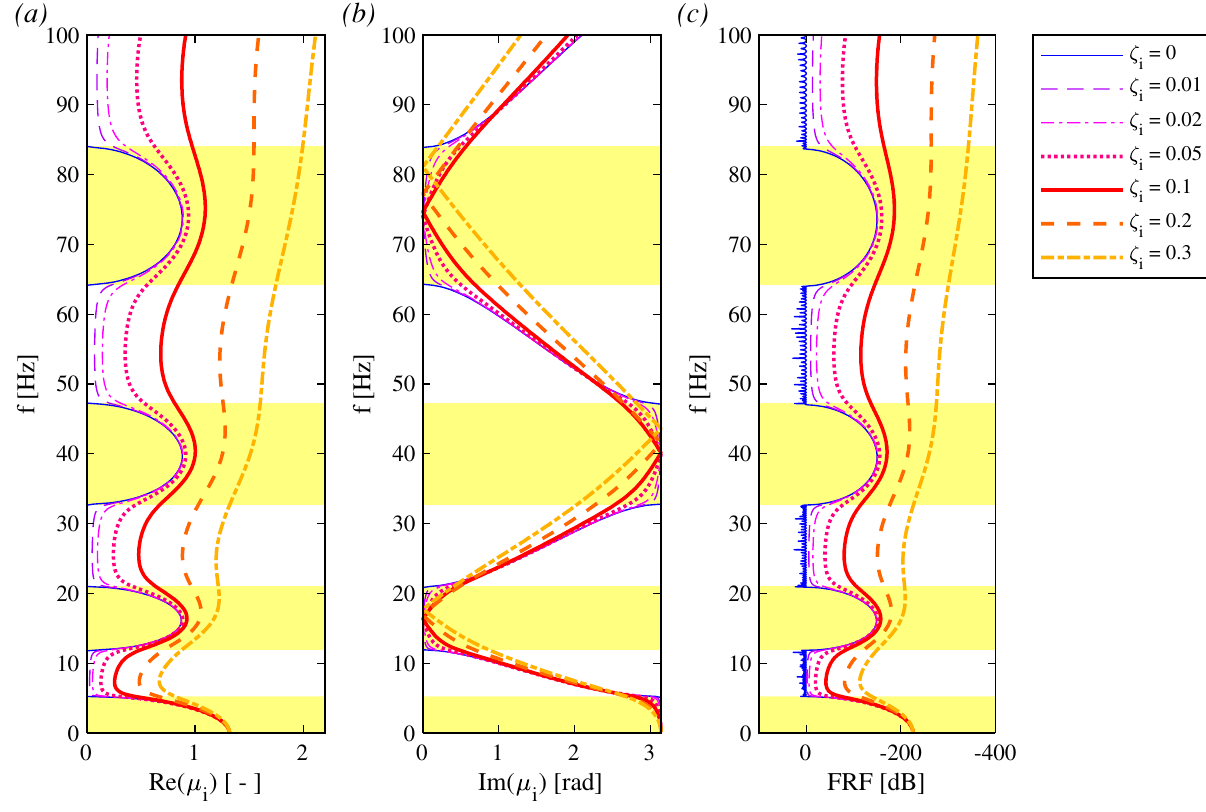
Figure 7. Dispersion curves for an internally damped PPR r as ( a ) function of the real part of μ i , ( b ) function of the imaginary part of μ i ; ( c ) numerical FRF of the finite periodic (40 spans) FEM. The bandgaps are indicated in